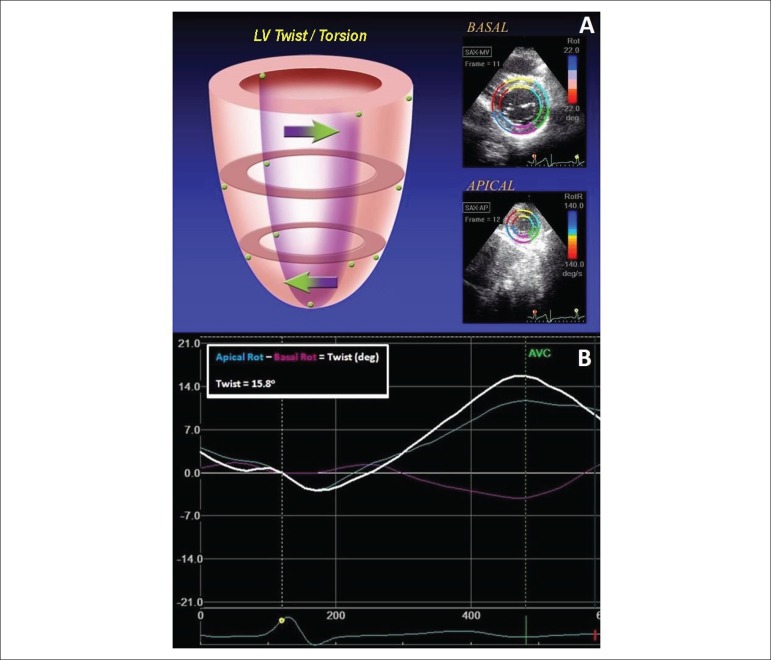
A: Representation of LV twist/torsion - clockwise rotation at the
base and counterclockwise at the apex (view from the apex). B:
Example of LV twist analysis (white line, LV twist; cyan line,
apical rotation; pink line, basal rotation).